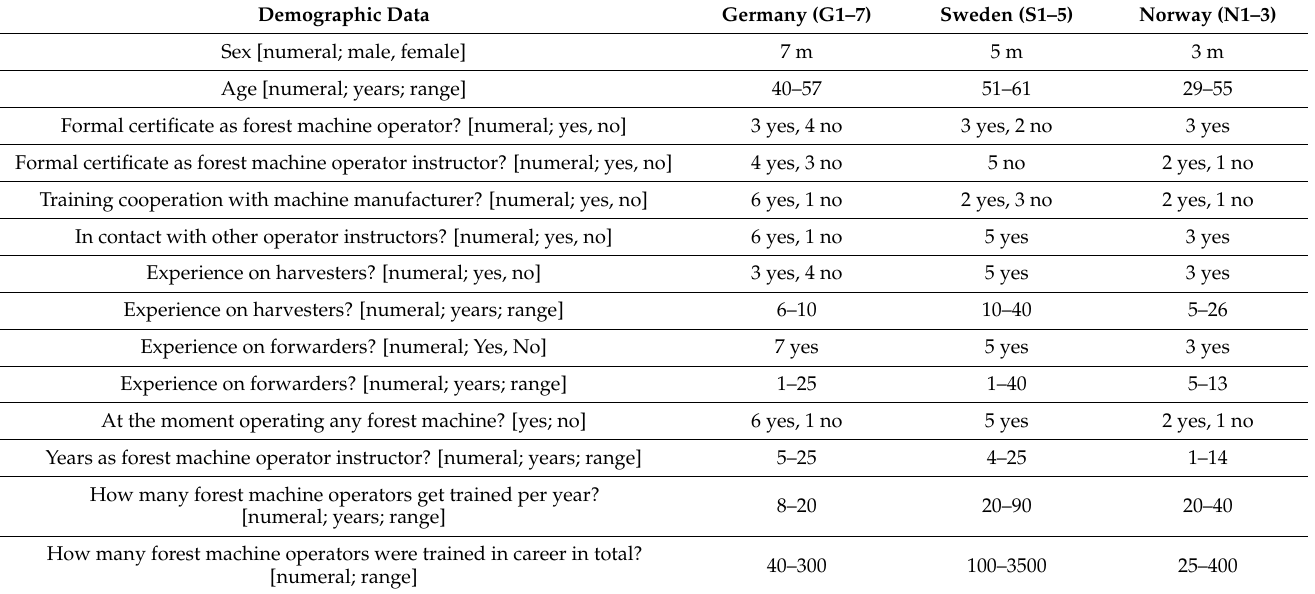
Table 1. Demographic data of the operator instructor interviews conducted in Germany, Sweden, and Norway (number ranges only apply to present